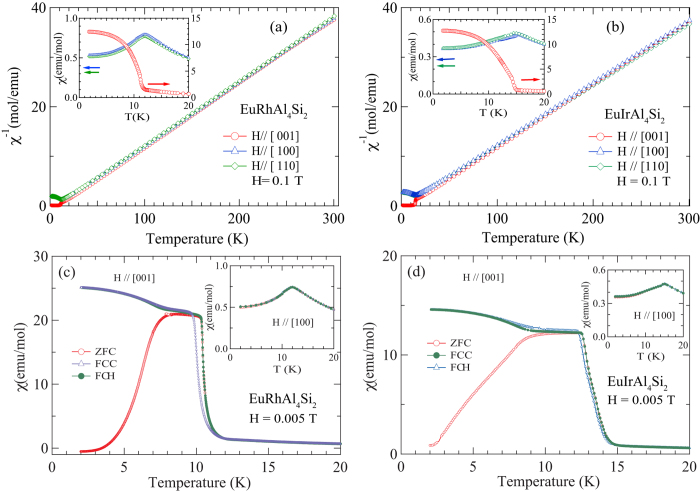
Inverse magnetic susceptibility of (a) EuRhAl4Si2 and (b) EuIrAl4Si2 along [001], [100] and [110] crystallographic directions. The insets show the anisotropy in the low temperature susceptibility. (c–d) The magnetic susceptibility in a field of 0.005 T: zero field cooled (ZFC), field cooled cooling (FCC) and field cooled heating (FCH) data for H ‖ [100] and H ‖ [001].